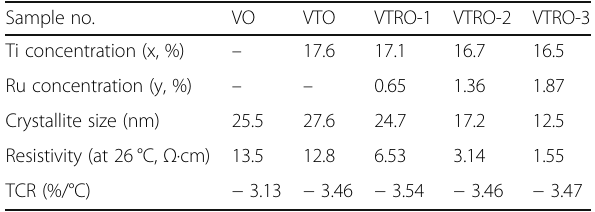
Table 1 Doping levels of Ti and Ru, crystallite size, resistivity, and TCR of all the samples Sample